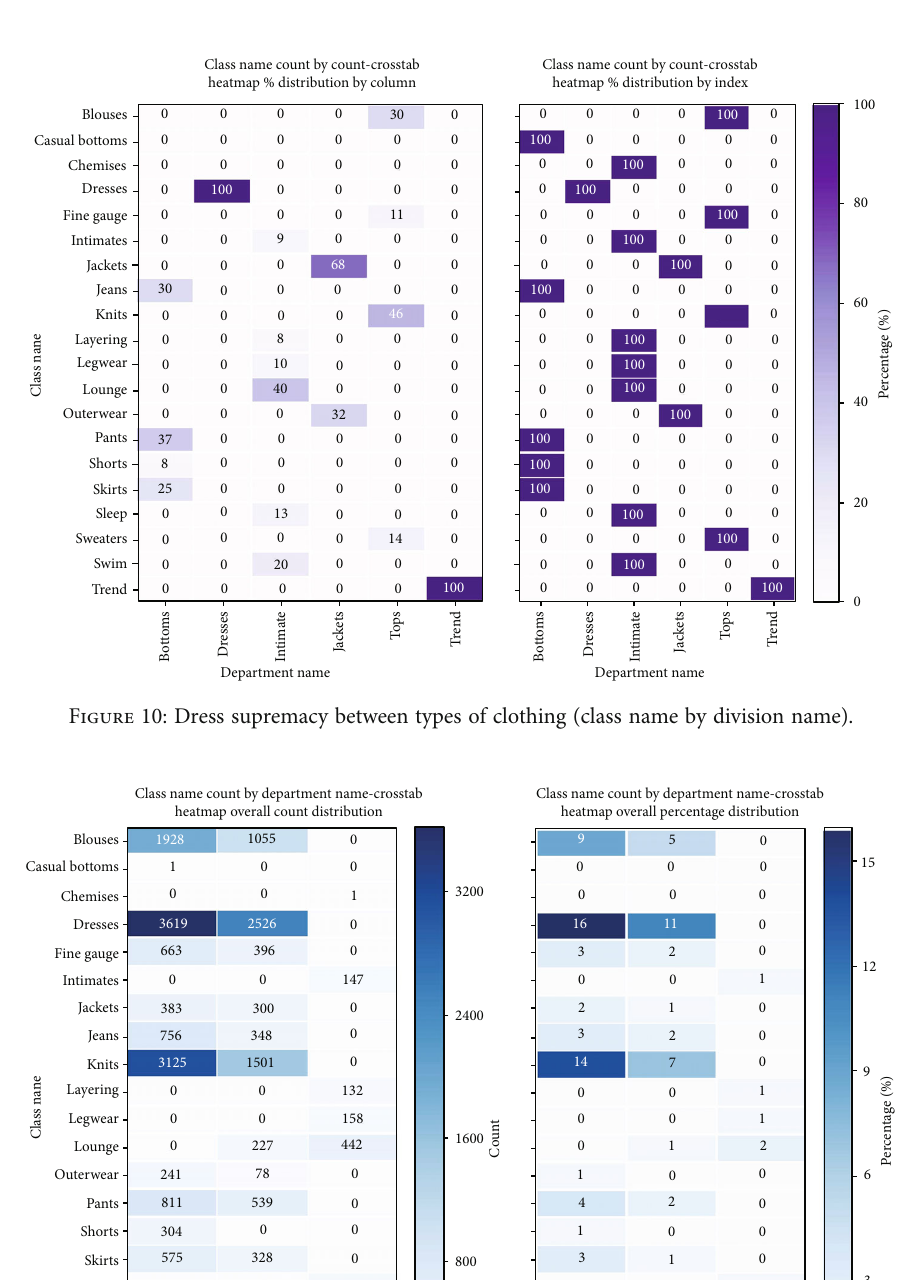
the department : Figure 7 indicates that the general-sized top was the most dominant commodity. The dominance of general size within the department name was consistent